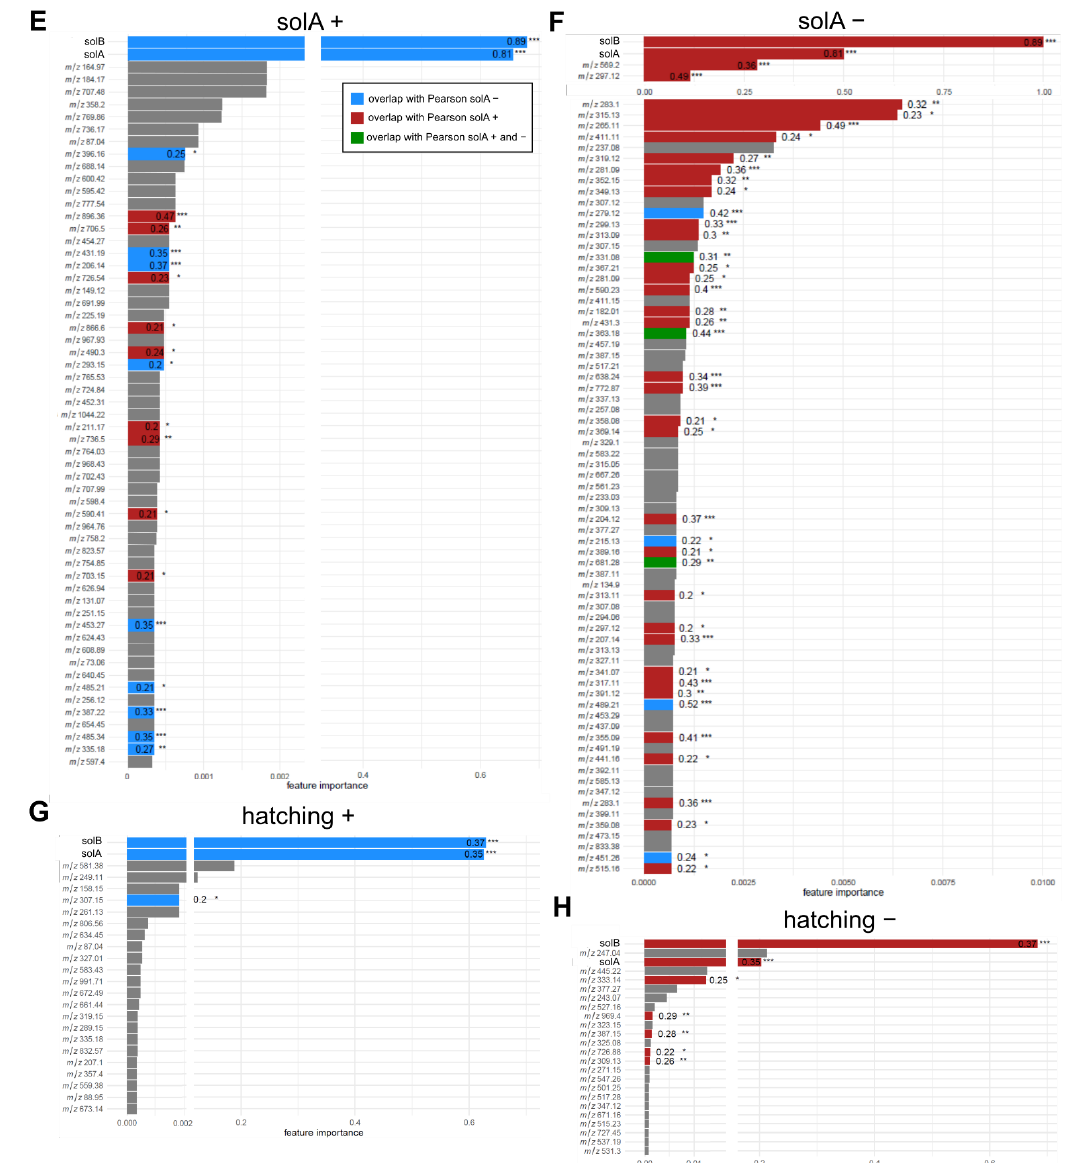
Figure 2. ( A–D ): m / z values of features in root exudate samples detected by LC-ESI-QTOF-MS analysis linearly correlating (Pearson) with ( A , B ) solA and ( C , D ) hatching in positive mode ( A , C ) and negative mode ( B , D ). The features in the (Pearson) correlograms are ordered according to the correlation coefficient using “hclust” method (corrplot package in R). ( E – H ): random forest feature selection from LC-ESI-QTOF-MS root exudate data for ( E ) positive and ( F ) negative modes with solA measured by UHPLC-MS/MS (solA_MRM) and positive ( G ) and negative modes ( H ) with hatching. The features that were also detected with Pearson’s correlation analysis, in the same mode (positive or negative), are marked in red. Features that were detected with Pearson’s correlation analysis in the opposite mode are marked in blue. Features that were detected with Pearson’s correlation analysis in the same as well as in the opposite modes are marked in green. Their Pearson’s correlation coefficients are displayed in or next to the bar. The cut-off for the Pearson’s correlation coefficient was 0.1. Only statistically significant ( p < 0.05) Pearson’s correlations are marked. The degree of significance is marked by stars: *** p < 0.001, ** p < 0.01, and * p < 0.05. Retention times of features in root extracts and root exudates are not comparable, since they were run on a different column, although of the same